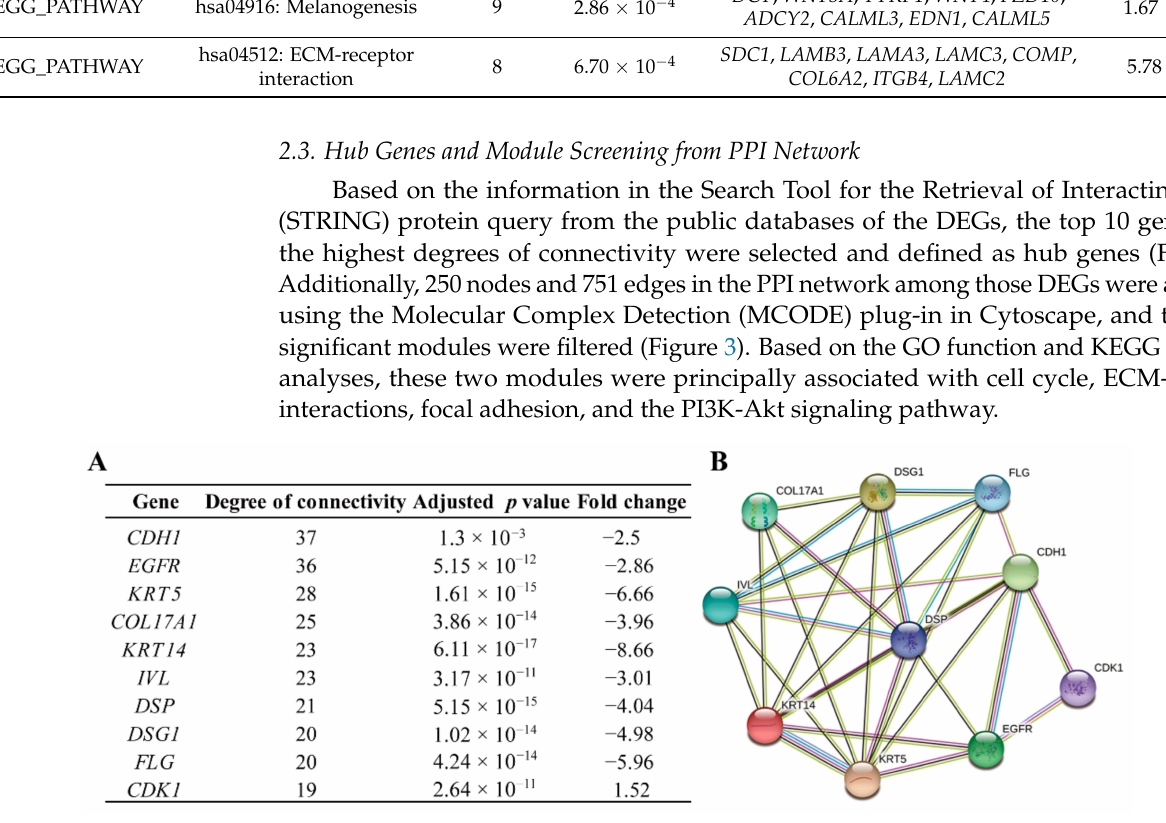
Figure 2. Top 10 hub genes with the highest degrees of connectivity. ( A ) Hub genes are listed. ( B ) The PPI network of the top 10 hub